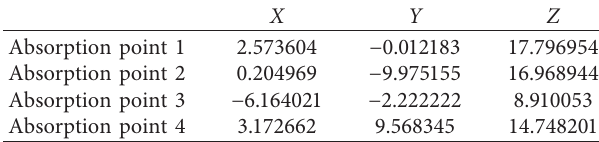
Table 4: The coordinates of absorption points.